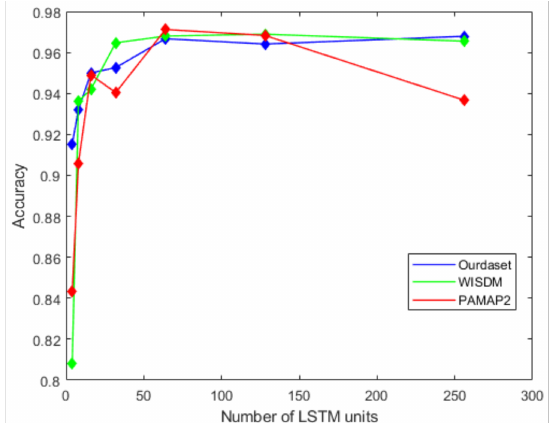
Figure 11. The effect of the number of LSTM units on recognition